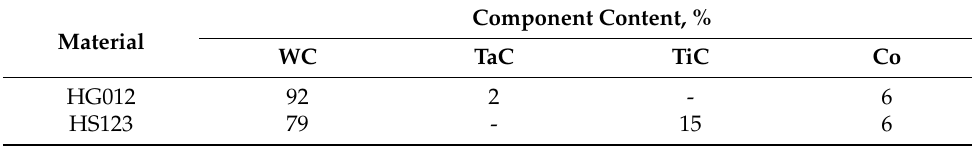
Table 1. The chemical composition of HG012 and HS123 hard alloys.